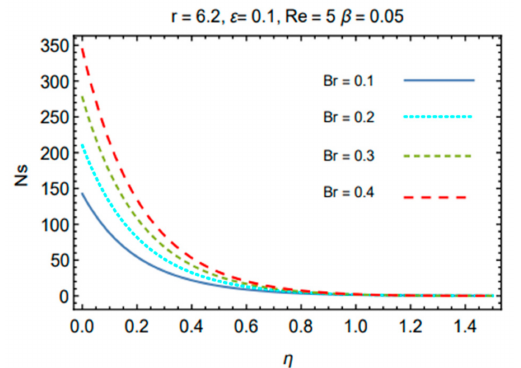
Figure 9. Variation in Ns against Br.